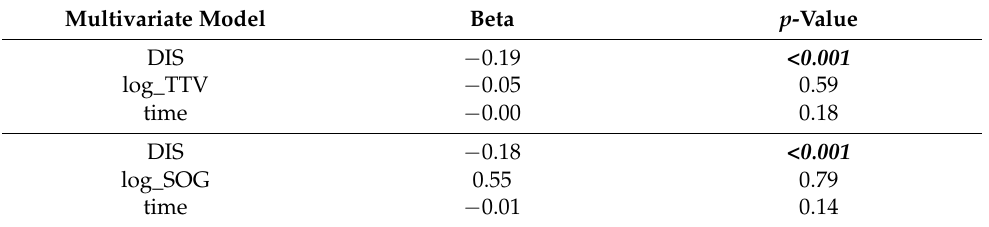
Table 3. Multivariate linear mixed model on hemoglobin. DIS: diffuse infiltration score; log_TTV: log-transformed total tumor volume summing up the volumes of all focal lesions; log_TTV-dynamic: log-transformed value of the dynamic of the total tumor volume over time; beta: model estimate. Significant findings are given in bold and italic